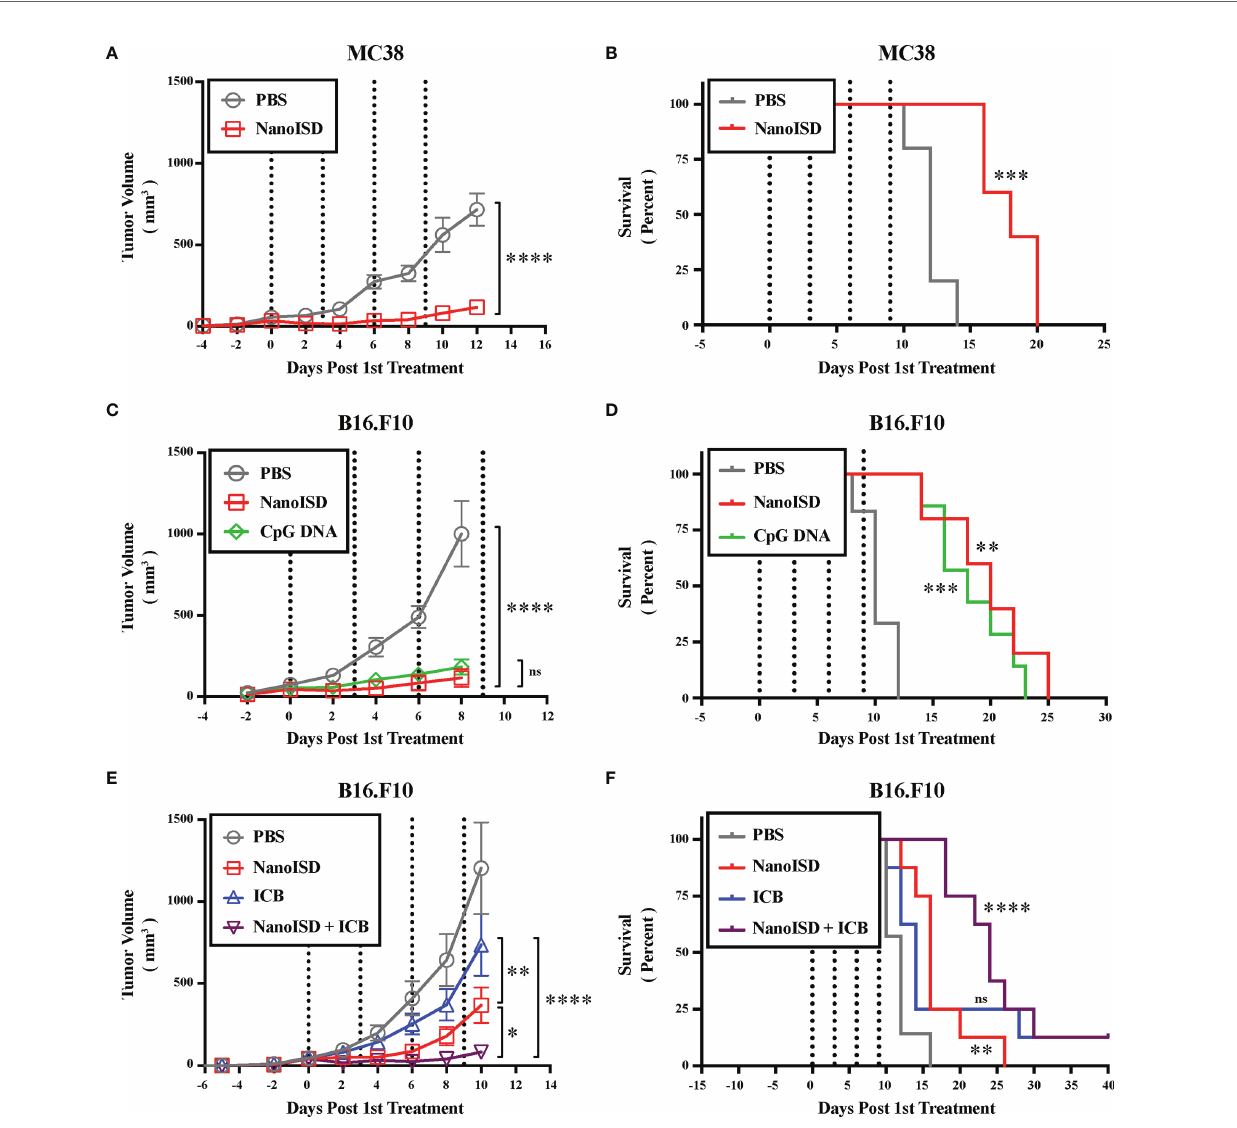
FIGURE 7 | NanoISD Exerts Antitumor Effects. (A) Tumor growth plot for MC38 tumors intratumorally treated with 100 µL of either PBS or NanoISD at a dose corresponding to 2 µg DNA (n = 5 per treatment group). Treatments were administered four times q3d as indicated by the dotted lines. Tumor growth curves were truncated to the fi rst day that a mouse in any treatment group reached the study endpoint. A two-way ANOVA with Sidak test was used for statistical analysis. The statistical analysis presented is for the fi nal day shown ( i.e. day 12). (B) Kaplan-Meier survival curve for MC38 tumors intratumorally treated with 100 µL of either PBS or NanoISD. Log rank (Mantel-Cox) test was used for statistical analysis. (C) Tumor growth plot for B16.F10 tumors intratumorally treated with 100 µL of either PBS, CpG DNA ( i.e. ODN 1826), or NanoISD (n = 5 or greater per treatment group). Both the CpG DNA and NanoISD doses corresponded to 2 µg DNA. Treatments were administered four times q3d as indicated by the dotted lines. Tumor growth curves were truncated to the fi rst day that a mouse in any treatment group reached the study endpoint. A two-way ANOVA with Tukey test was used for statistical analysis. The statistical analysis presented is for the fi nal day shown ( i.e. day 8). (D) Kaplan-Meier survival curve for B16.F10 tumors intratumorally treated with 100 µL of either PBS, CpG DNA ( i.e. ODN 1826), or NanoISD. Log rank (Mantel- Cox) test was used for statistical analysis. (E) Tumor growth plot for B16.F10 tumors treated with 100 µL of either PBS, ICB ( i.e. anti-PD-1 + anti-CTLA-4 monoclonal antibody therapy), NanoISD, or NanoISD + ICB (n = 8 per treatment group). NanoISD and PBS were administered intratumorally, while ICB was administered intraperitoneally. The NanoISD dose corresponded to 2 µg DNA. The ICB treatment corresponded to 100 µg of both anti-PD-1 and anti-CTLA-4 monoclonal antibodies. Treatments were administered four times q3d as indicated by the dotted lines. Tumor growth curves were truncated to the fi rst day that a mouse in any treatment group reached the study endpoint. A two-way ANOVA with Tukey test was used for statistical analysis. The statistical analysis presented is for the fi nal day shown ( i.e. day 10). (F) Kaplan-Meier survival curve for B16.F10 tumors treated with 100 µL of either PBS, ICB ( i.e. anti-PD-1 + anti-CTLA-4 monoclonal antibody therapy), NanoISD, or NanoISD + ICB ( i.e. anti-PD-1 + anti-CTLA-4 monoclonal antibody therapy). Log rank (Mantel-Cox) test was used for statistical analysis. ****p < 0.0001, ***p < 0.005, **p < 0.01, *p < 0.05. ns, not signi fi